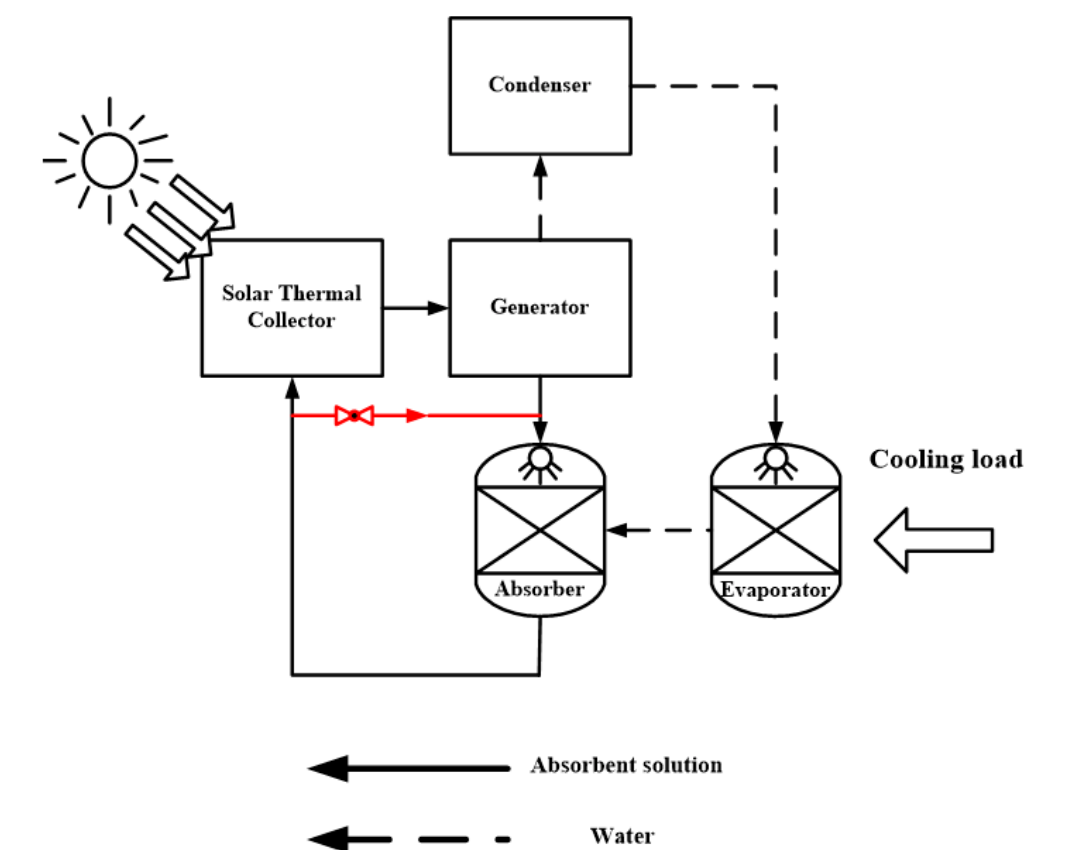
Figure 1. Flow chart of solar energy driven absorption air-conditioning